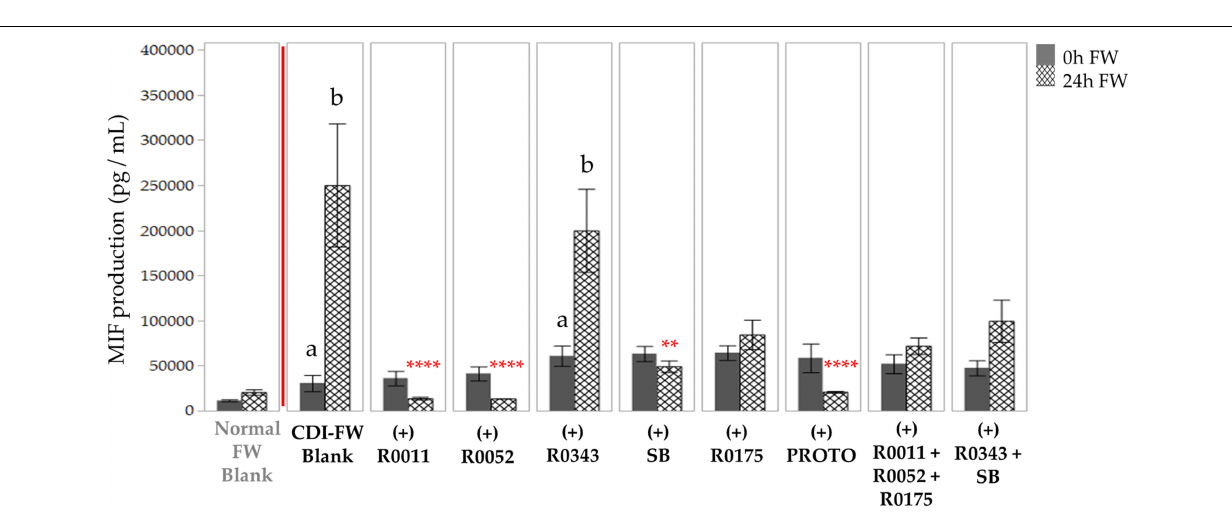
FIGURE 4 | Detection of C-X-C motif chemokine 5 production following the exposure of T84 cells to Clostridioides difficile -infected (CDI) fecal water (FW) treatments. , cells treated with FW collected at T = 0 h; , cells treated with FW collected at T = 24 h. Values are shown as mean ± SEM. Means at time points within treatments without a common letter are significantly different ( p < 0.05). The symbol * represents significant differences (* p < 0.05; ** p < 0.01) between treatment and CDI-FW blank at T = 24 h. R0011 = L. rhamnosus R0011; R0052 = L. helveticus R0052; R0343 = L. rhamnosus GG R0343; SB = S. boulardii CNCM I-1079; R0175 = B. longum R0175; PROTO = ProtecFlorTM; R0011 + R0052 + R0175 = combination of L. rhamnosus R0011, L. helveticus R0052 and B. longum R0175; R0343 + SB = combination of L. rhamnosus GG R0343 and S. boulardii CNCM I-1079.